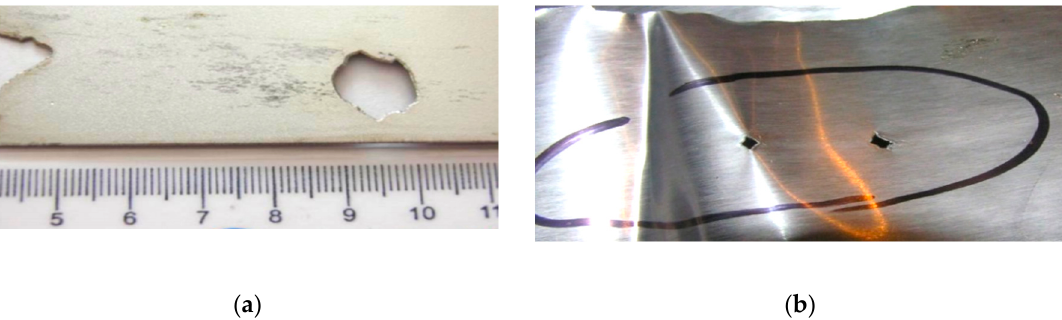
Figure 8. Samples from metallographic analysis ( a ) Holes in the strip after metallurgical sliver falls out after the rolling process (cm); ( b ) Holes in the strip after metallurgical sliver falls out after the rolling process.